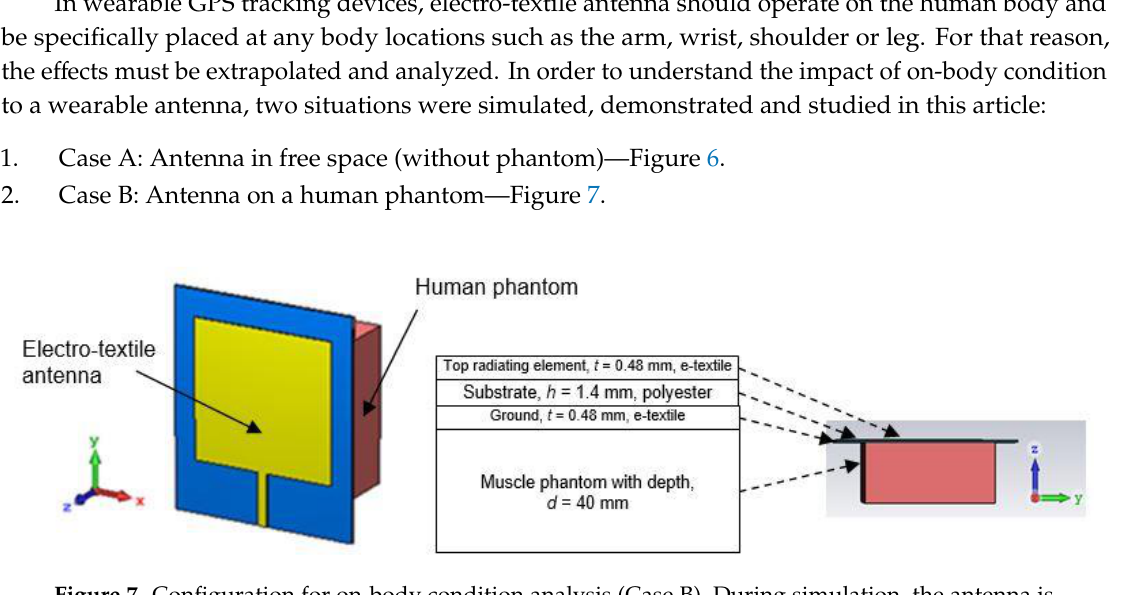
Figure 7. Configuration for on-body condition analysis (Case B). During simulation, the antenna is attached to the human phantom with various dielectric constant,  r and conductivity,  to represent the exact properties of human body fat, muscle and blood.